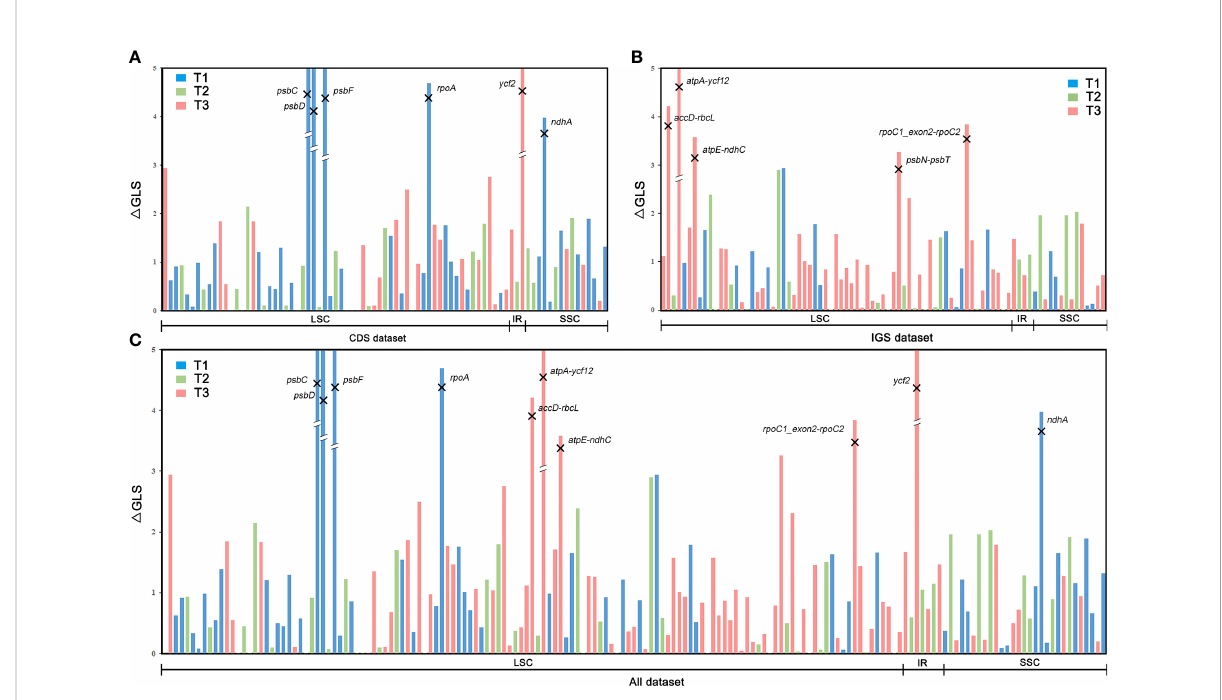
FIGURE 5 Distribution of phylogenetic signal supporting the three alternative topologies for the phylogenetic position of Dennstaedtiaceae based on gene-wise log-likelihood scores ( D GLS) across the (A) CDS, (B) IGS, and (C) All